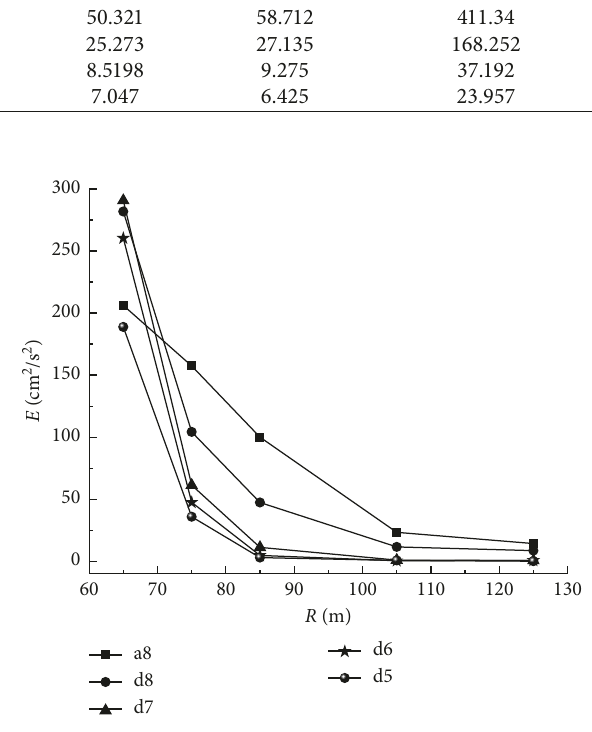
Figure 8: Attenuation laws of the total energies along with